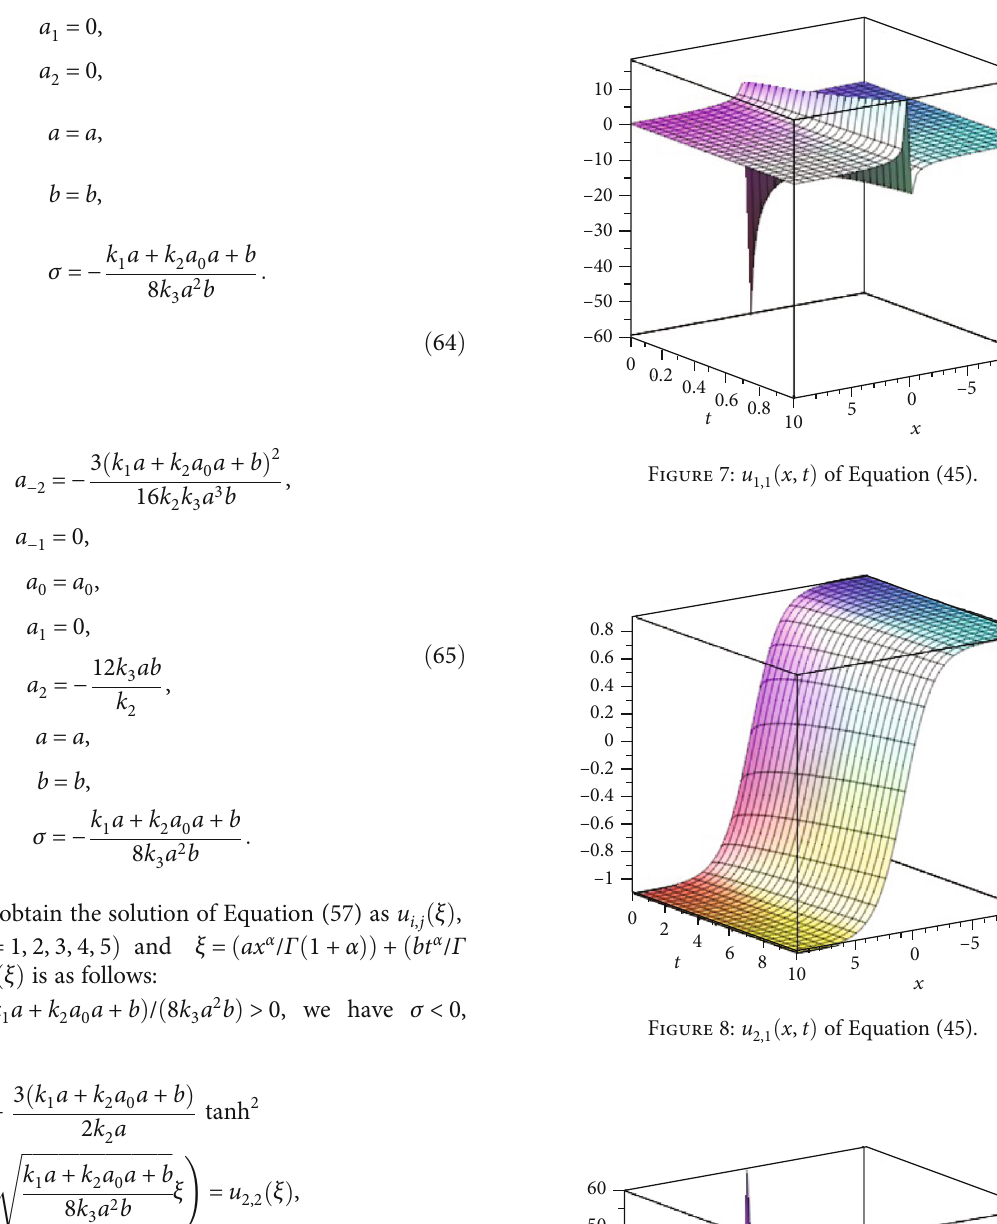
ffiffiffiffiffiffiffiffiffiffiffiffiffiffiffiffiffiffiffiffiffiffiffiffiffiffiffiffiffi